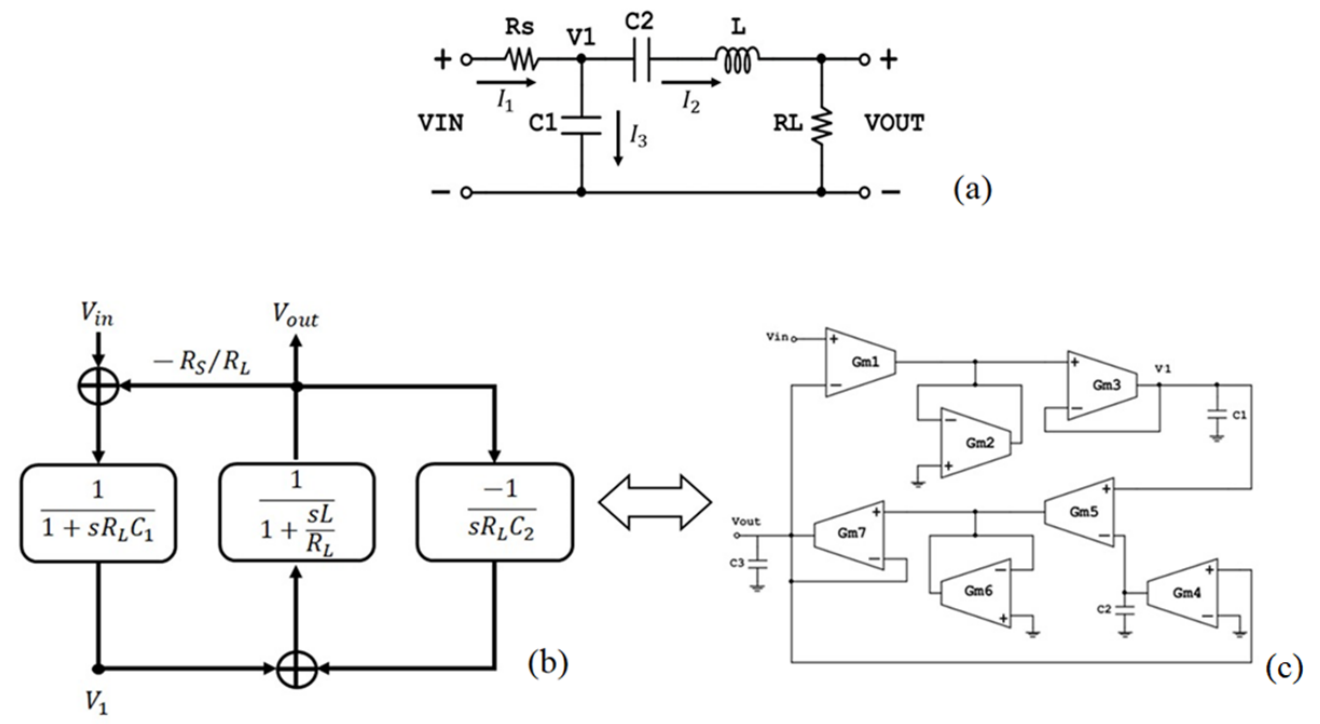
Figure 10. ( a ) OTA-based 3rd Order Bandpass Filter implementation, ( b ) Signal flow, and ( c ) Leapfrog Figure 10. (a) OTA-based 3rd Order Bandpass Filter implementation, (b) Signal flow, and (c) Leap- technique (RLC two port frog technique (RLC two port topology).